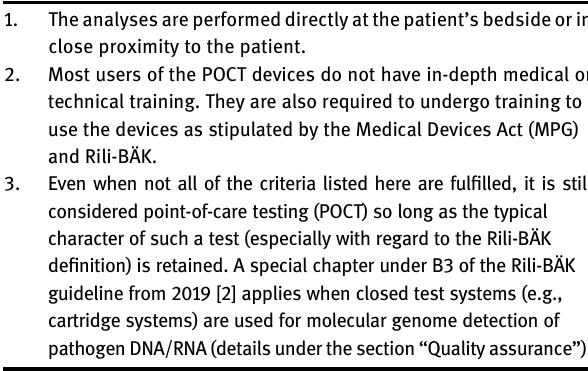
Table  : Additional characteristics of point-of-care testing